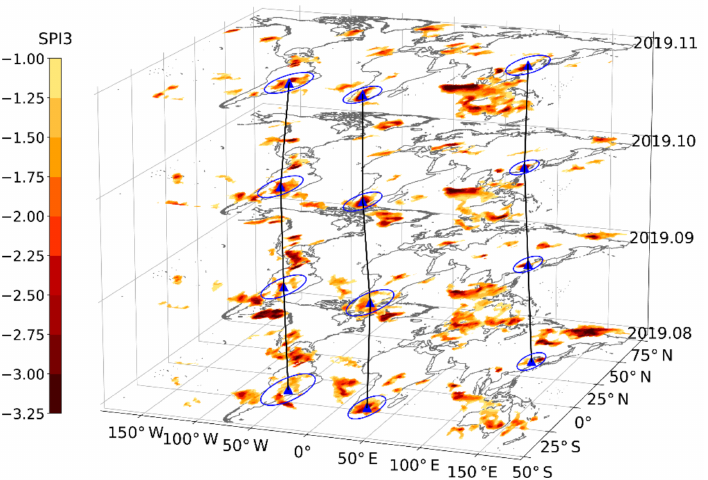
Figure 3. Global drought evolution from August to November in 2019. The droughts in China, South Africa, and South America are marked respectively, where the black line represents the evolution of a drought, the blue triangle represents the center of a drought at a time step, and the blue circle covers the drought area